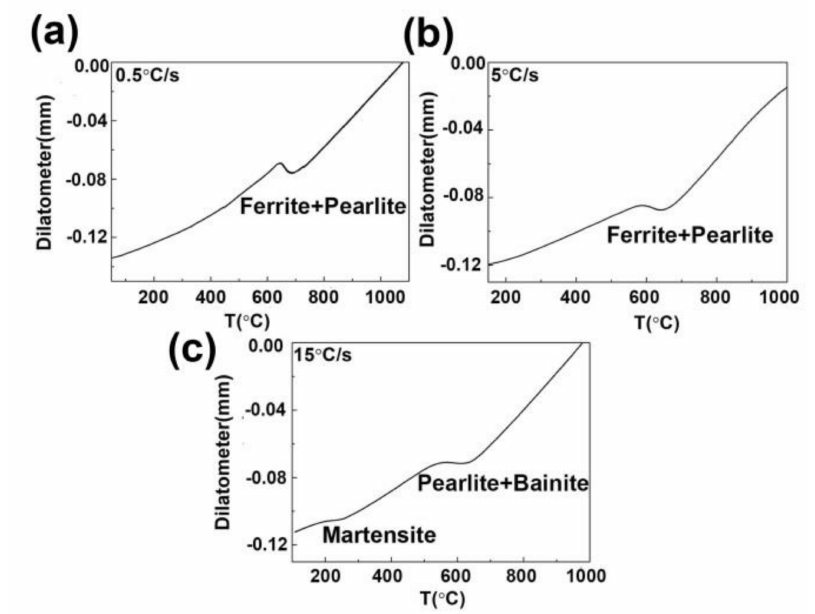
Figure 4. Dilatometric curves of the deformed specimen cooled at ( a ) 0.5 ◦ C / s, ( b ) 5 ◦ C / s, and ( c ) 15 ◦ C / s.